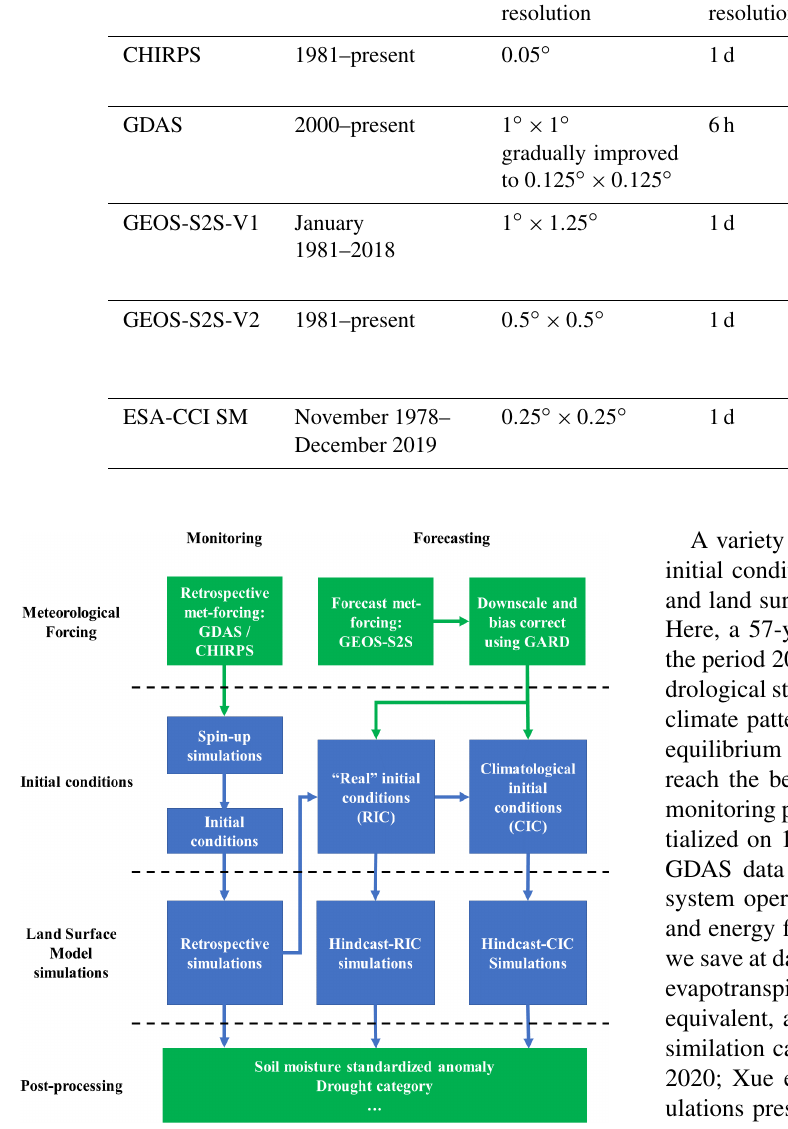
Figure 2. A schematic workflow of the South and Southeast Asia monitoring and forecasting system. Retrospective simulations (open-loop), hindcasts with “Real” initial condition (hindcast-RIC) simulations, and hindcasts with climatological initial condition (hindcast-CIC) simulations are designed to evaluate the monitoring and forecasting